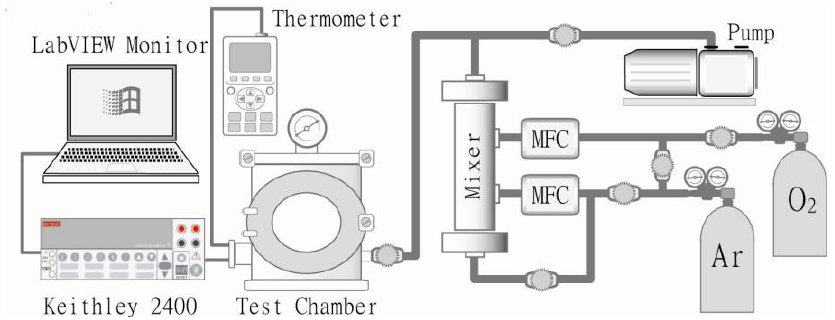
Figure 5. A configuration schematic of the gas test